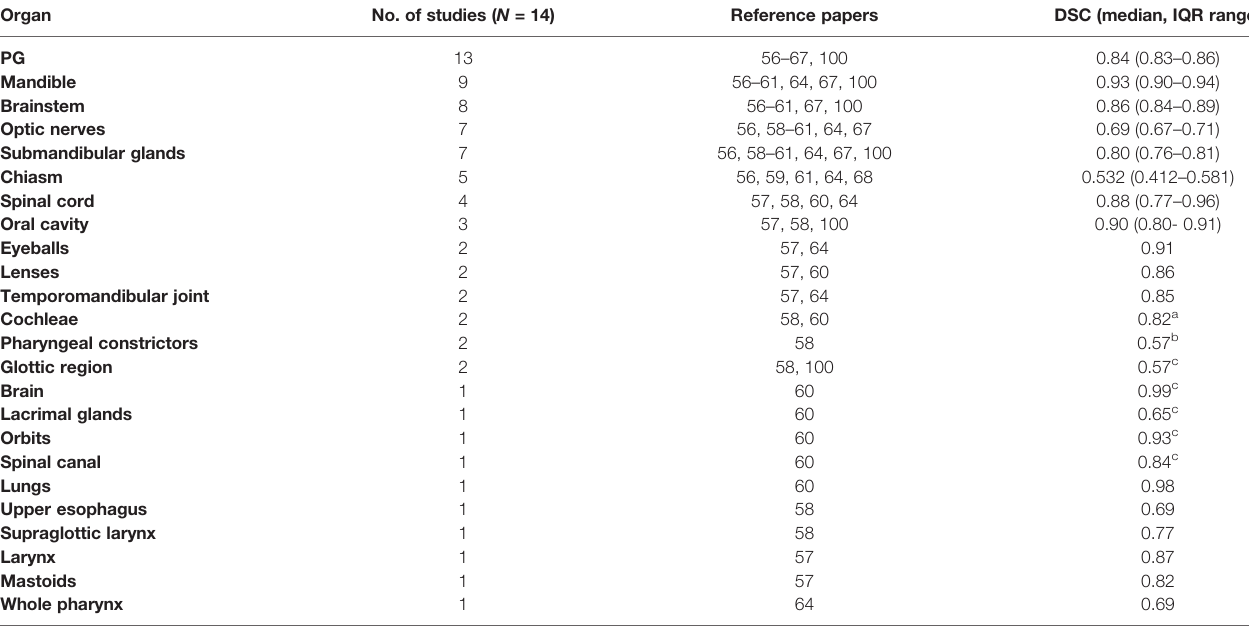
TABLE 2 | Reported Dice Similarity Coef fi cient (DSC) in literature for different organs. Organ No. of studies ( N =